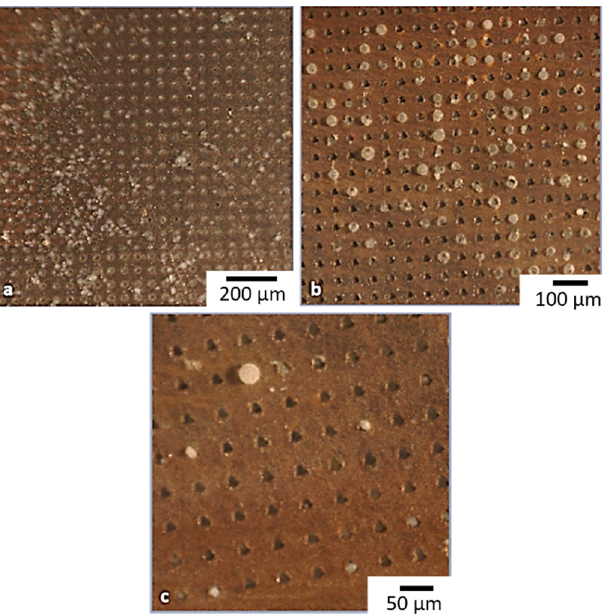
Figure 10. ( a ) Gold-coated CKC membranes used for cell migration experiments after functionali- zation with FBS. Cells spread over the whole surface on the seeding side. ( b ) and magnification in ( c ) 24 h after seeding, the membrane was observed on the reverse side (migration side). As can be seen cells sprout out from the pores thus demonstrating that membranes can be used in migration assays.